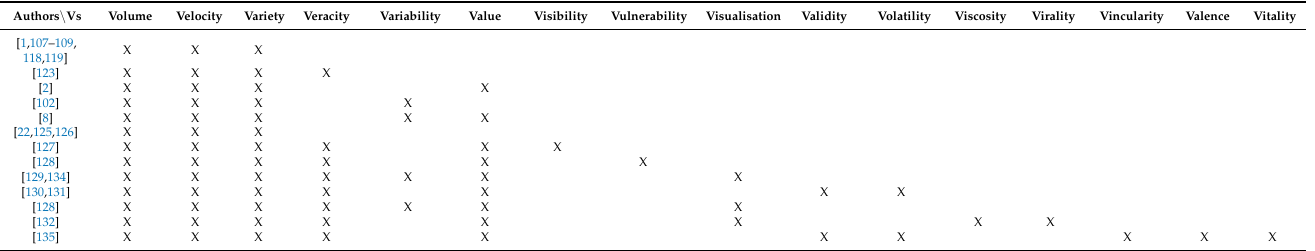
Table 4. Vs literature